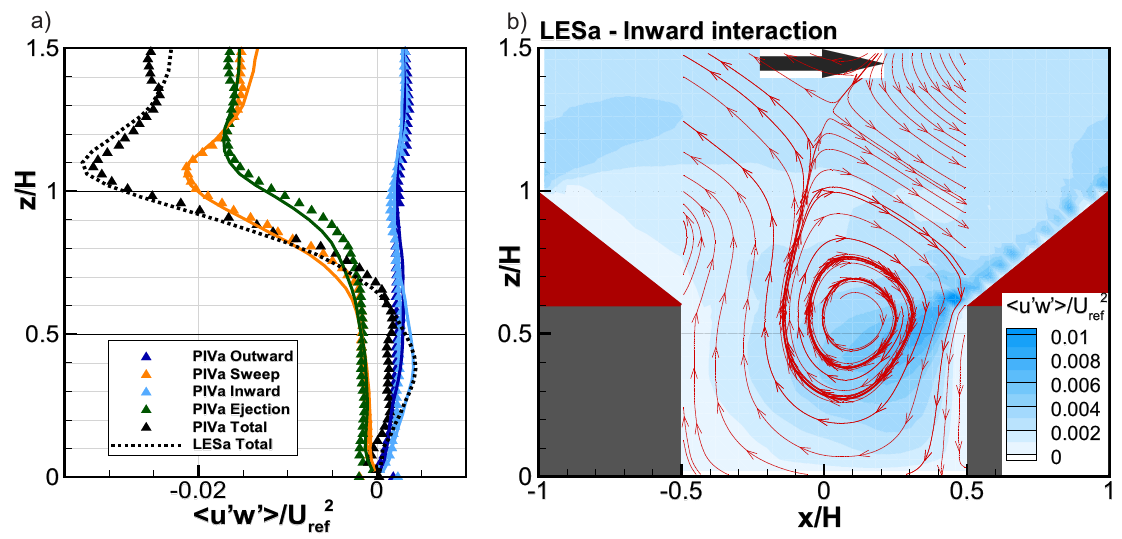
Figure 6. ( a ) The vertical profiles of the total vertical momentum flux and the particular event contributions to the total momentum flux from LESa (lines) and PIVa (triangles) at position x / H = 0. The colours correspond to the schematic diagram of the quadrant analysis in the bottom left corner in Figure 7; ( b ) 2D plane of the inward interaction from LESa (light blue contours) with the red streamlines of the second POD mode from LESa.